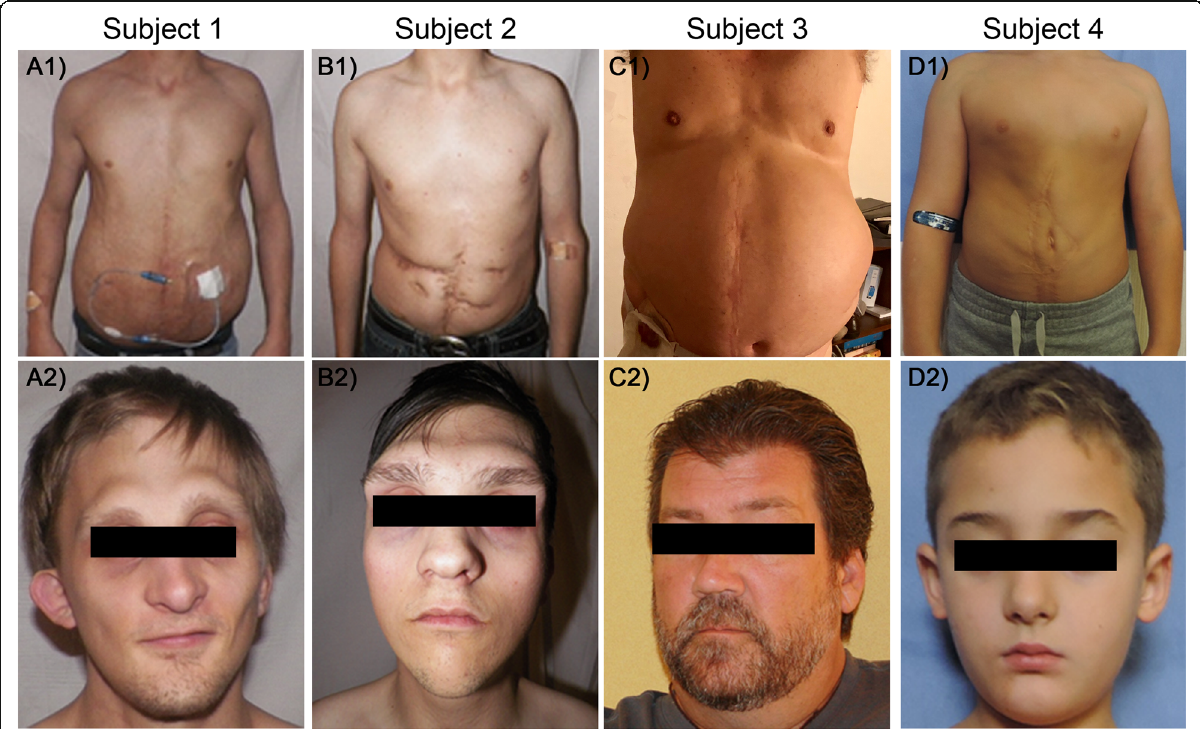
Fig. 1 Thoraco-abdominal and Facial Photographs of 4 PBS affected individuals with FLNA mutations. A1-A2 ) Pedigree 1 Subject 1 (p.C2160R) has a RUBACE severity score of 22 and syndromic PBS with additional OPDSD features including prominent supraorbital ridge and micrognathia ( A2 ). B1-B2) Pedigree 1 Subject 2 (p.c2160R) has a RUBACE severity score of 24 as well as syndromic PBS with OPDSD phenotypic features including prominent supraorbital ridge, micrognathia, facial asymmetry ( B2 ). He additionally has Pierre Robin Sequence. C1-C2 ) Pedigree 2 Subject 3 (p.A1448V) has a RUBACE severity score of 14 (isolated PBS). No strong OPDSD craniofacial features are noted ( C2 ). D1-D2) Pedigree 3 Subject 4 (p.G2236E) has a RUBACE severity score of 13 (isolated PBS). No strong OPDSD craniofacial features are noted ( D2